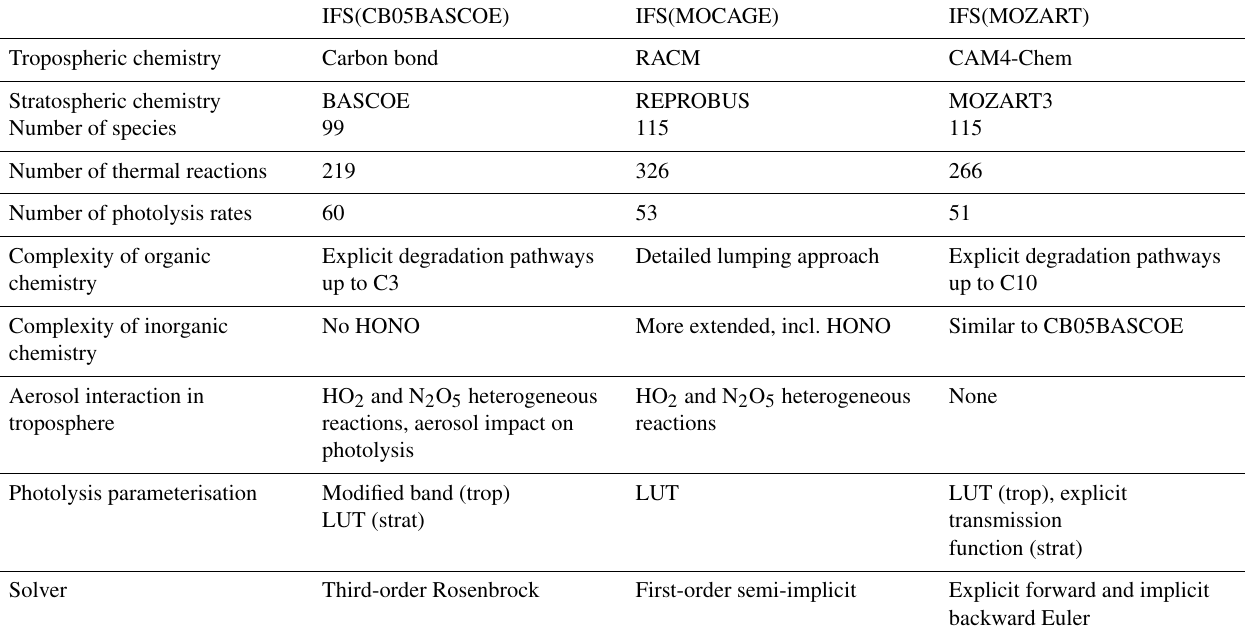
Table 1. Specification of elemental aspects describing the three chemistry